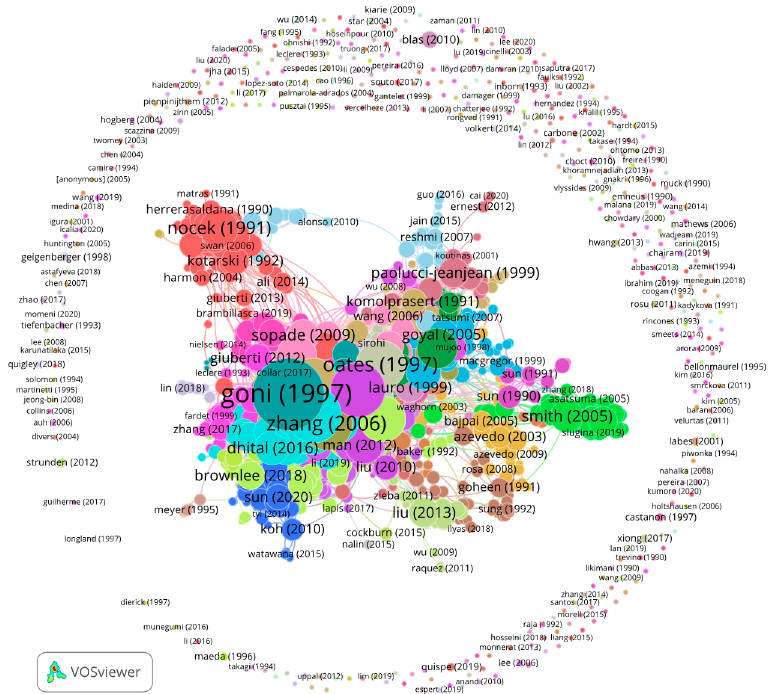
Figure A1. Citation network visualization of 2053 articles obtained from the WoS with 6178 links. The ring around the network core represents 509 articles with no links to the other articles. The article with the highest number of links (161) is Goñi et al., (1997), labelled goni (1997). Size of node reflects the number of links.